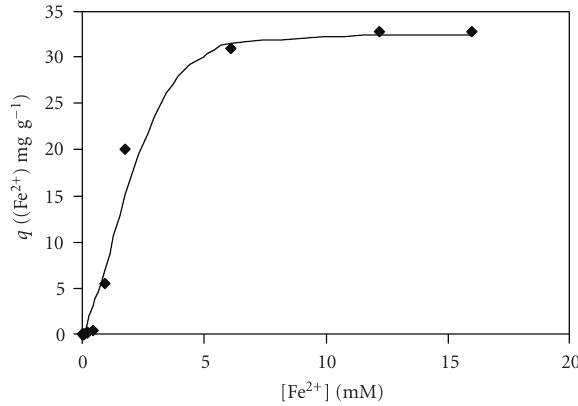
Figure 5: The surface concentration of Fe 2+ -ions on TiO 2 versus Fe 2+ -ions equilibrium concentration at pH 3 (20 ◦